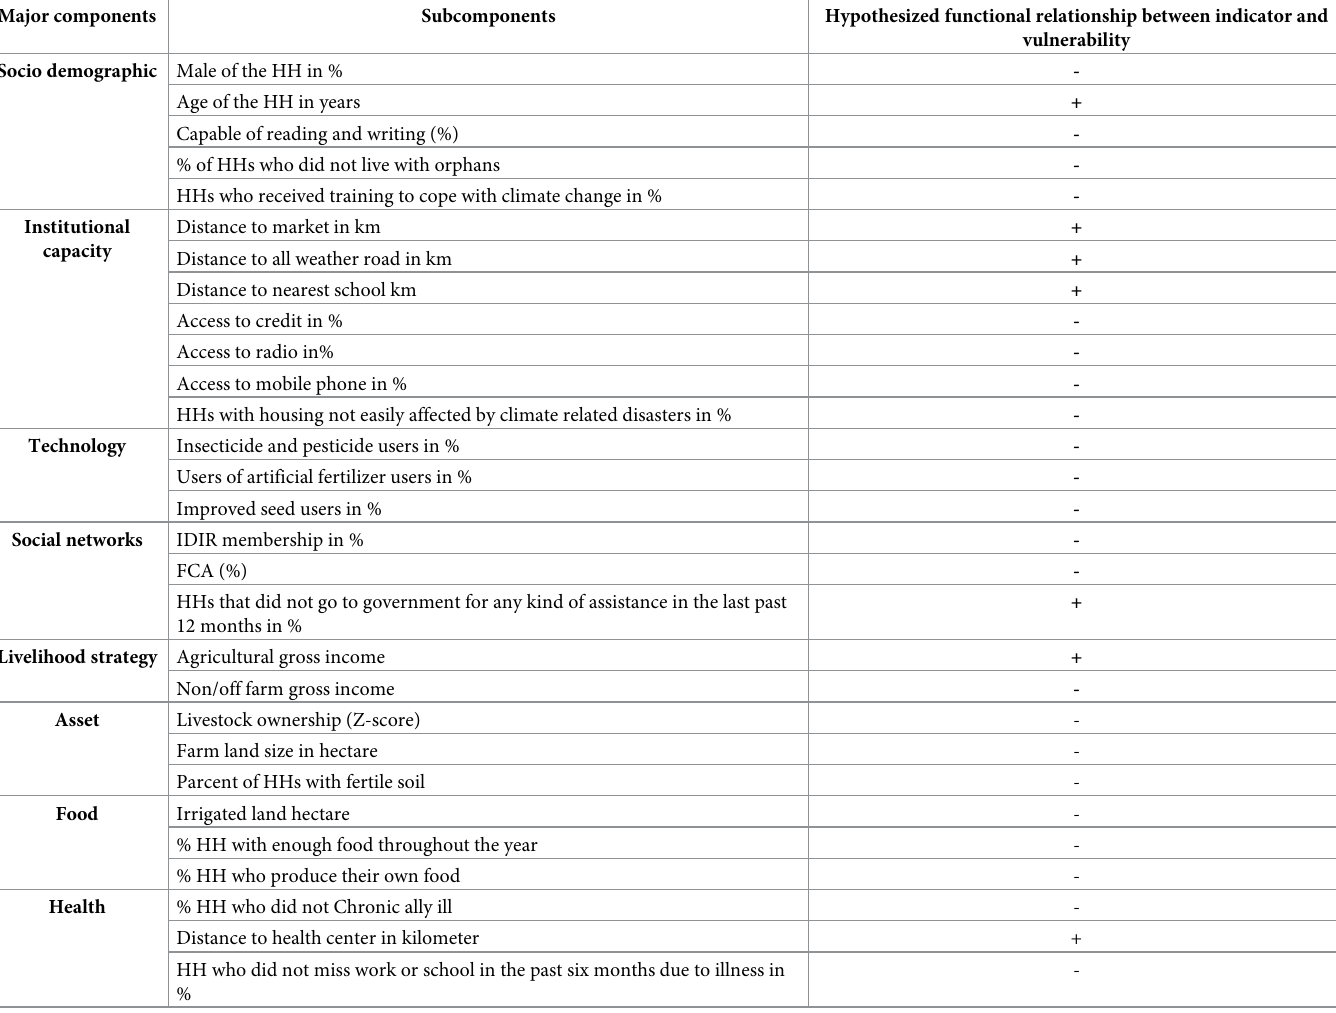
Table 1. Adaptive capacity major components, sub-components, and their hypothesized effect with vulnerability. Major